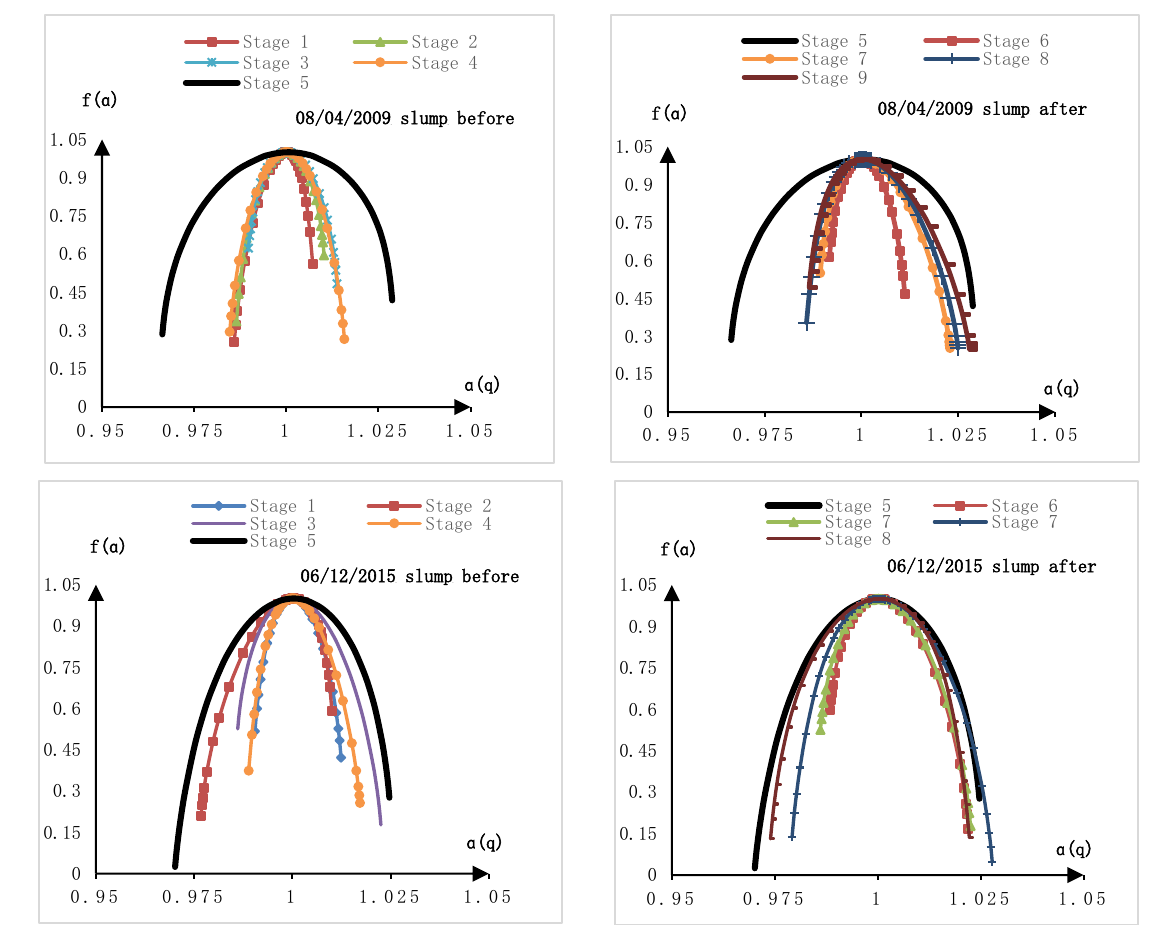
Figure 4. The temporal spectrum of the multifractal spectrum for eight slumps.